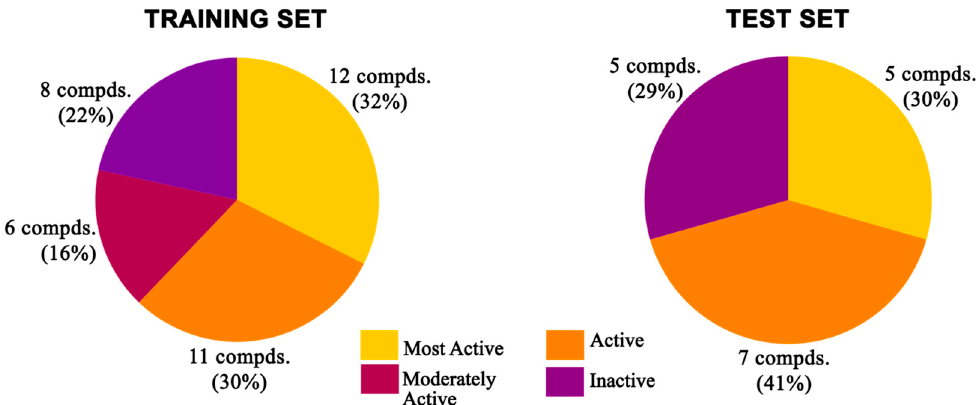
Figure 24. Distribution of different categories of compounds in training and test sets for 3D ‐ QSAR study.